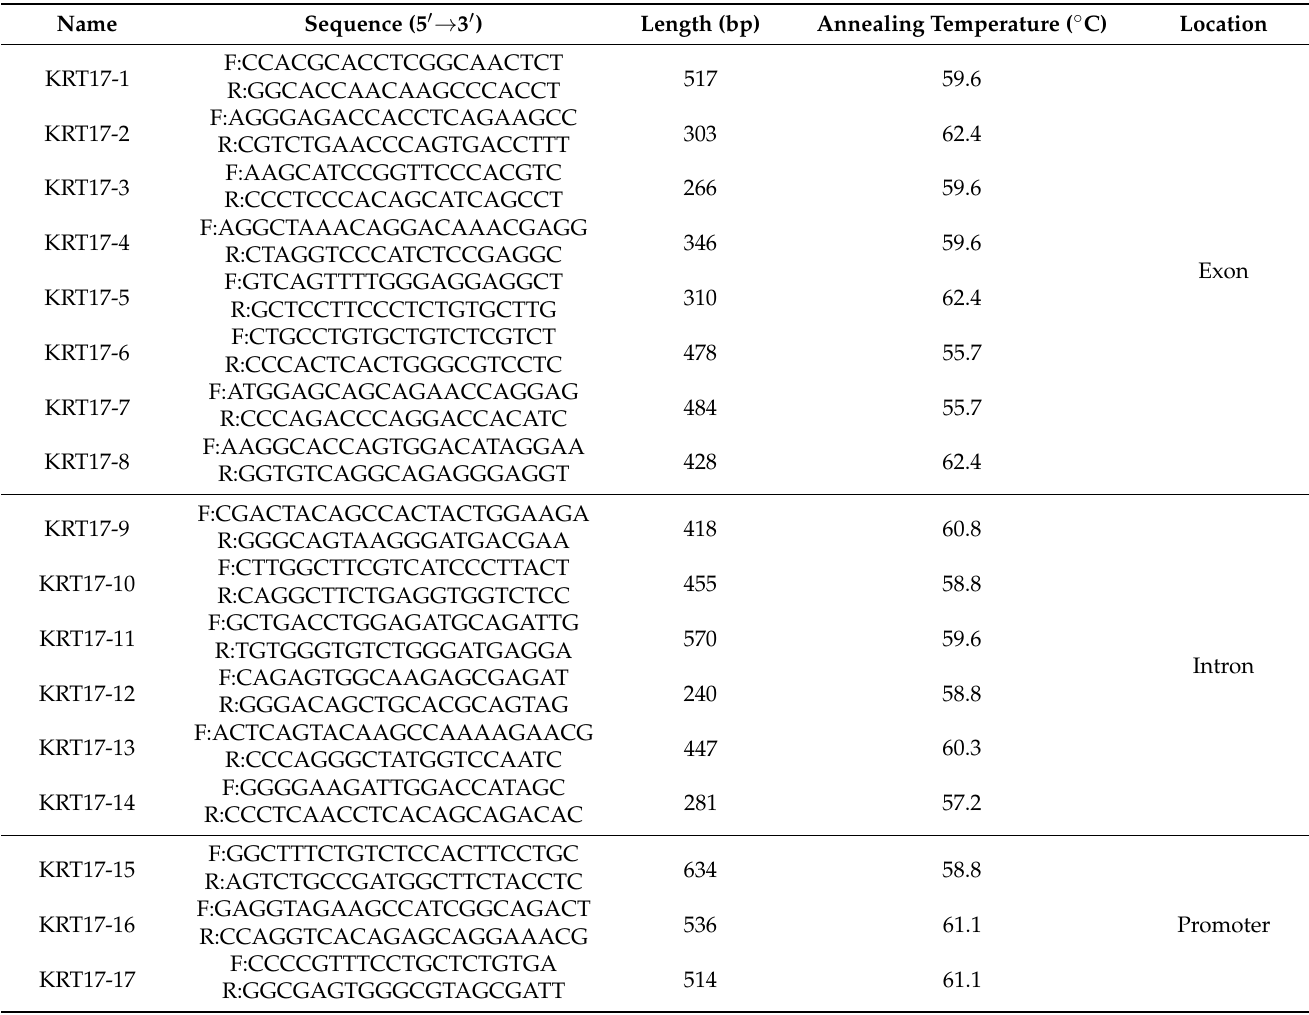
Table 9. Polymorphism detection primers to amplify the exons, introns, and promoter regions of the KRT17